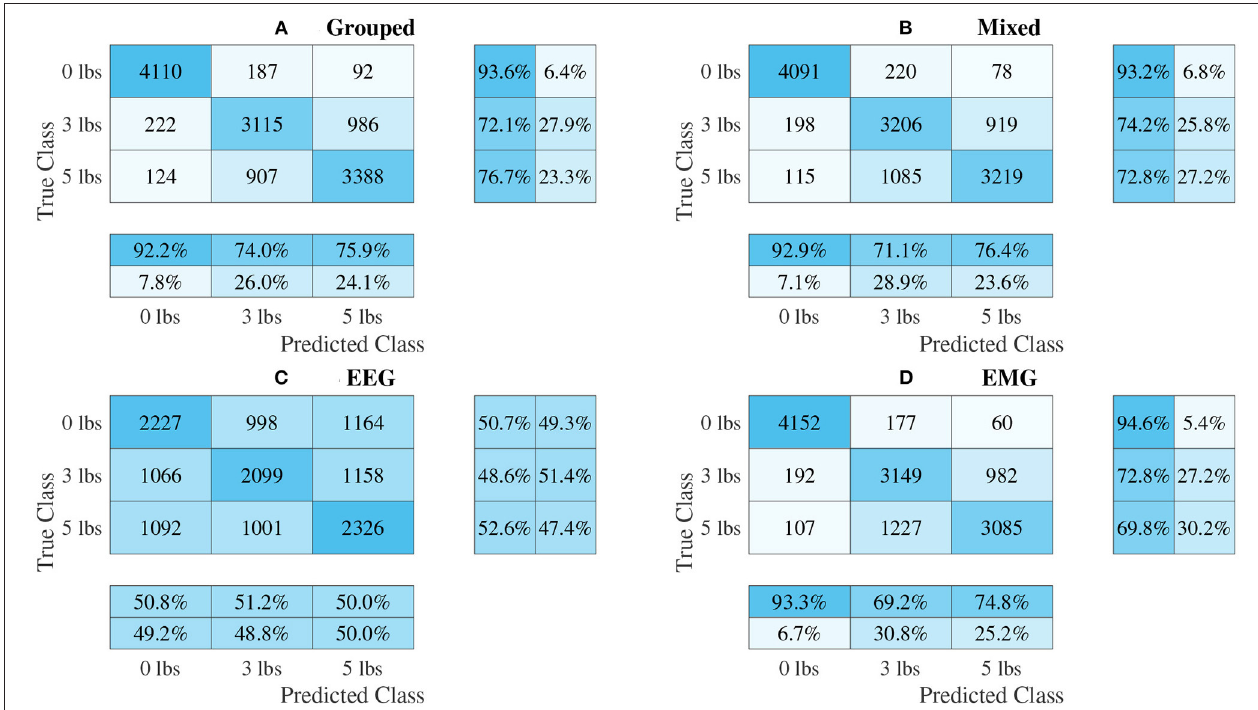
FIGURE 9 | Confusion matrices, using the combined classification results for all subjects, for the single-channel spectrogram-based CNN models. (A) Shows the matrix for the grouped fusion method while (B) shows the matrix for the mixed fusion method. (C,D) Show the matrices for the EEG and EMG only models, respectively. Each matrix contains a positive/negative precision score summary in the final two rows, and a positive/negative recall score summary in the final two